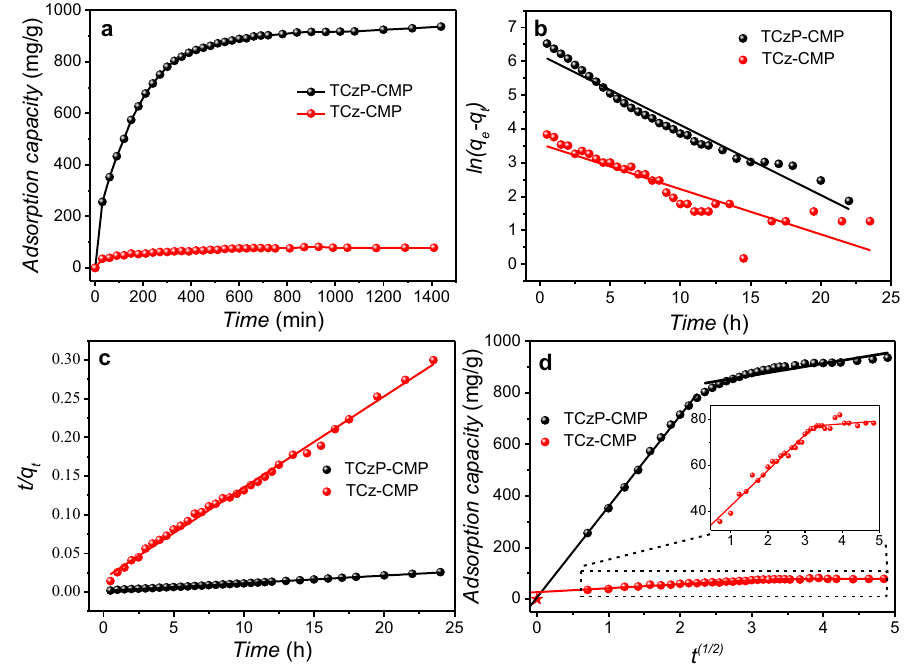
Fig. 4 | Adsorption performance of CMP to DCP vapors. a Adsorption capacity of the TCz-CMP and TCzP-CMP to DCP; b PFO model; c PSO model; d intra-particle diffusion model. The original adsorption data are in Source